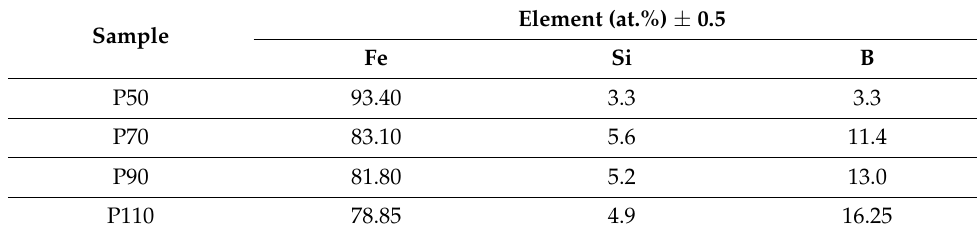
Table 5. Elemental analysis of the selective melted